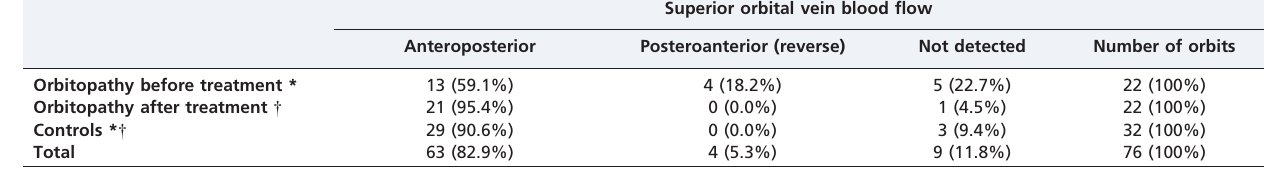
Table 1 - Detection and direction of blood flow in the superior ophthalmic vein using color Doppler imaging in patients with Graves’ orbitopathy and control